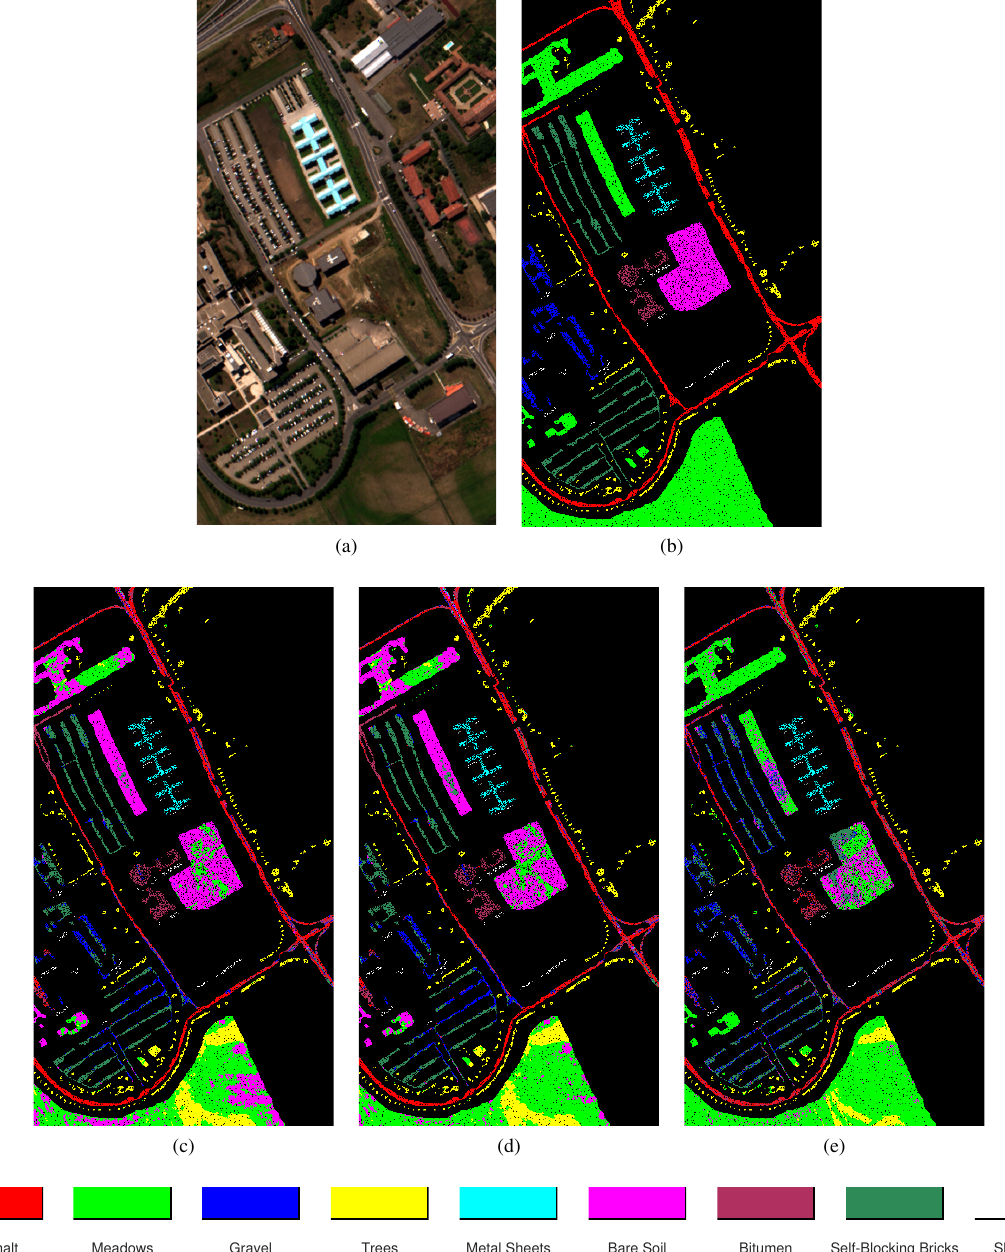
Figure 2. Class representation for the Pavia University hyperspectral dataset: (a)False color composition, (b) Ground truth and classification maps corresponding to the combination of the SVM classifier with the (b) PCA, (c) AE, and (d) HOAE dimensionality reduction